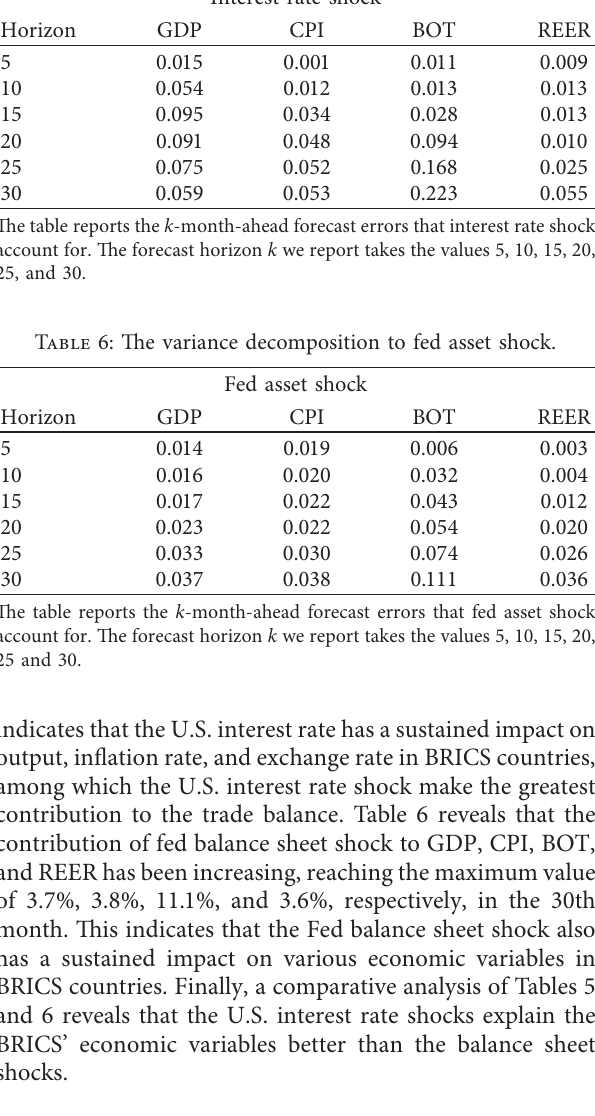
Table 5: The variance decomposition to interest rate shock. Interest rate shock